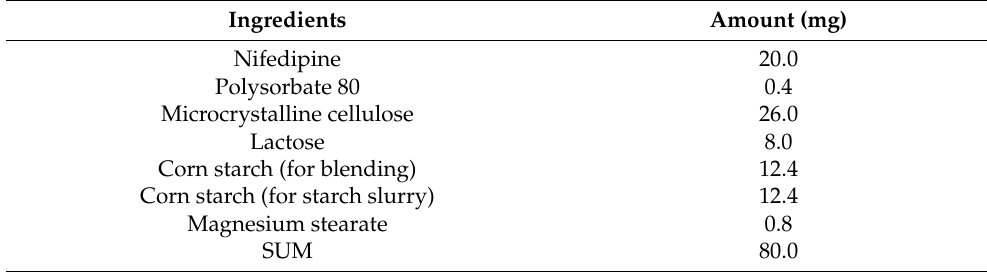
Table 1. Composition of core tablets.